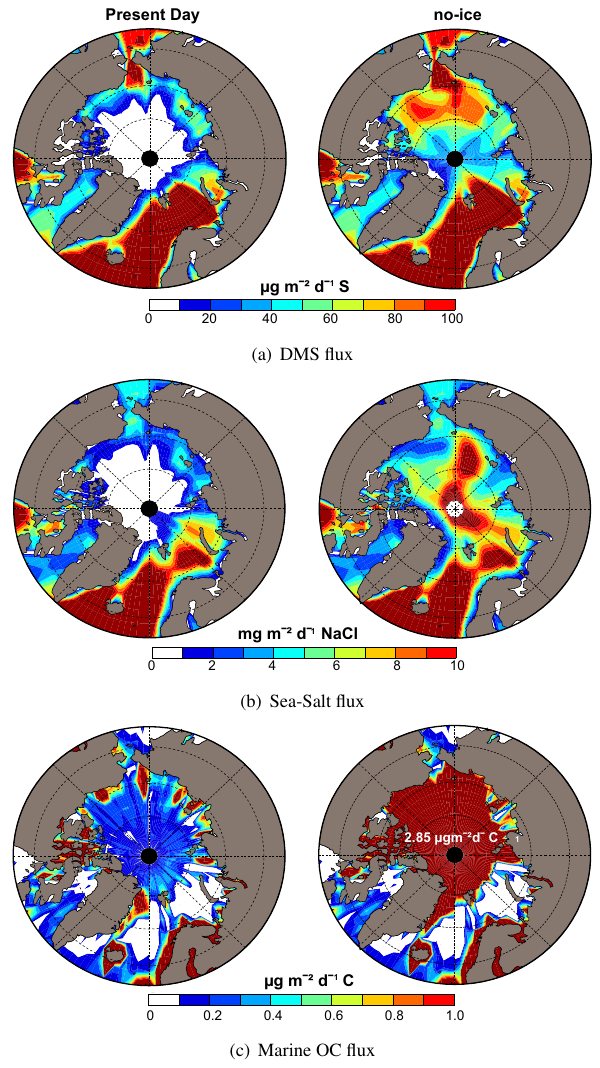
Fig. 2. (a) Dimethyl sulphide ( µ g m − 2 d − 1 S), (b) primary sea-salt (mg m − 2 d − 1 NaCl) and (c) and marine organic carbon ( µ g m − 2 d − 1 C) flux in the present day (left) and after sea-ice loss (right) (PD and no-ice model runs, respectively). As we have not split the primary OC emission tracer the organic carbon flux shown includes both our derived marine organic sea-surface flux (perturbed by sea-ice loss) and ship emissions (which are identical in each run).